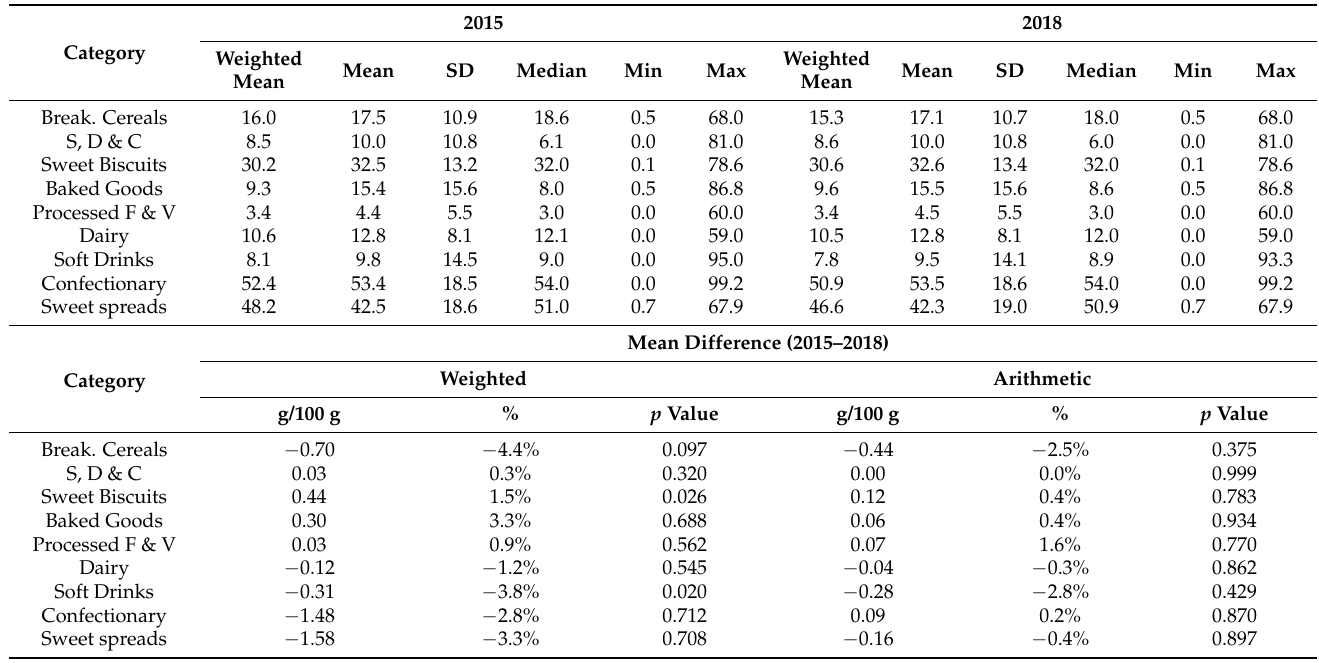
Table 2. Summary statistics and variations of total sugars content (in g/100 g or mL) for selected packaged food and soft drinks categories in Europe.